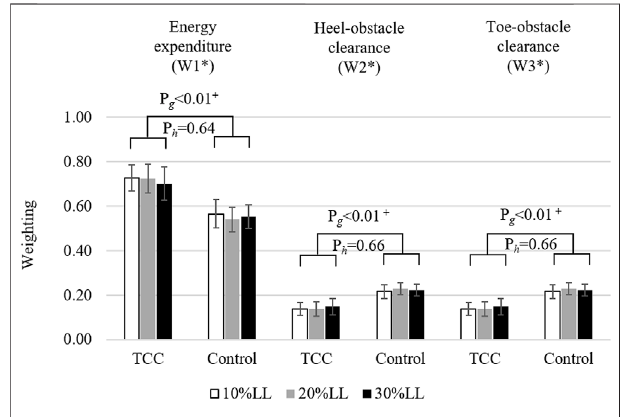
FIGURE 4 | Means (standard deviations) of the best-compromise weighting sets (W 1 *, W 2 *, W 3 *), corresponding to the objective functions of mechanical energy expenditure, heel-obstacle clearance, and toe-obstacle clearance of the MOOC problem, for the TCC and Control groups when crossingobstaclesofthreedifferentheights:10%(white),20%(grey)and30% (black) of individual subject ’ s leg length (LL). P -values for the main effects are also given (P g : group effects; P h : height effects). +: statistically signi fi cant differences between groups ( p < 0.05).